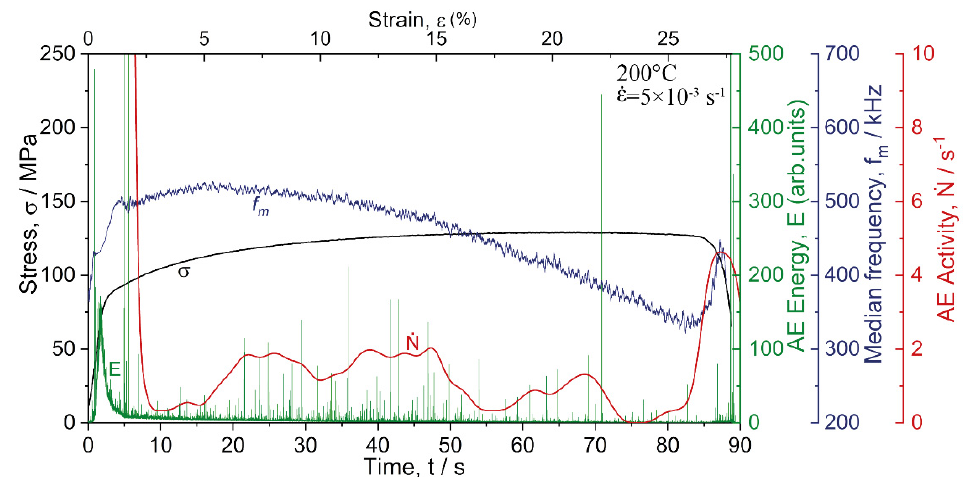
Figure 12. The acoustic emission diagram for the Mg-1Zn-0.2Ca alloy was tested at 200 °C (c.f., Fig- ure 7f) with the activity (number of signals per second shown by a red line) of the high-amplitude twinning-related AE bursts superimposed. twinning-related AE bursts